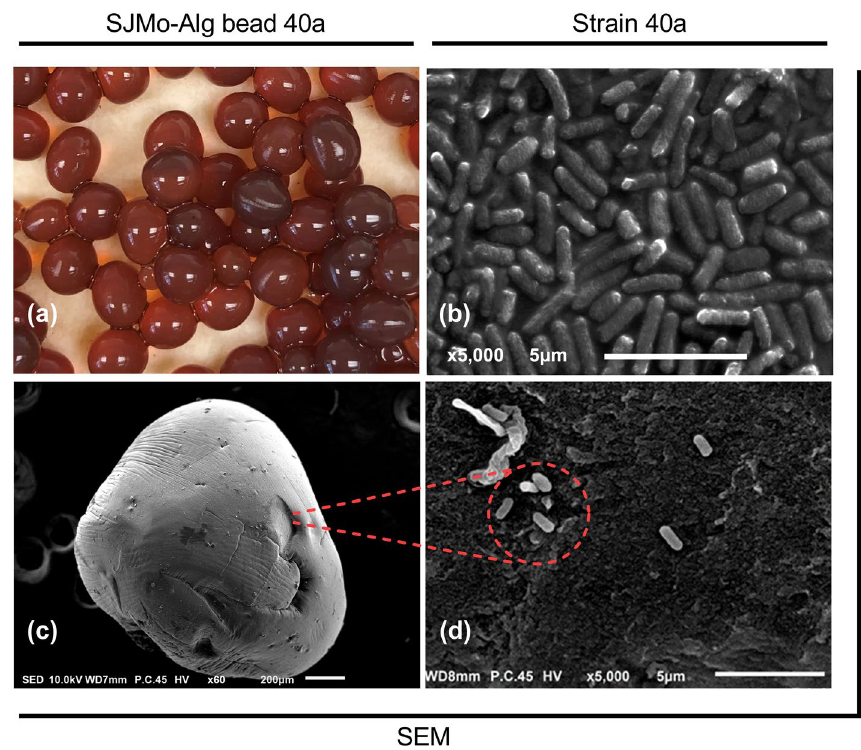
Figure 5. The visual image of SJMo-Alg bead 40a biofertilizer: ( a ) representative image of the freshly extruded bead; ( b ) SEM image of free cells of strain 40a; ( c ) SEM image of a single bead; ( d ) high magnification SEM image of encapsulated strain 40a on the surface of SJMo-Alg bead